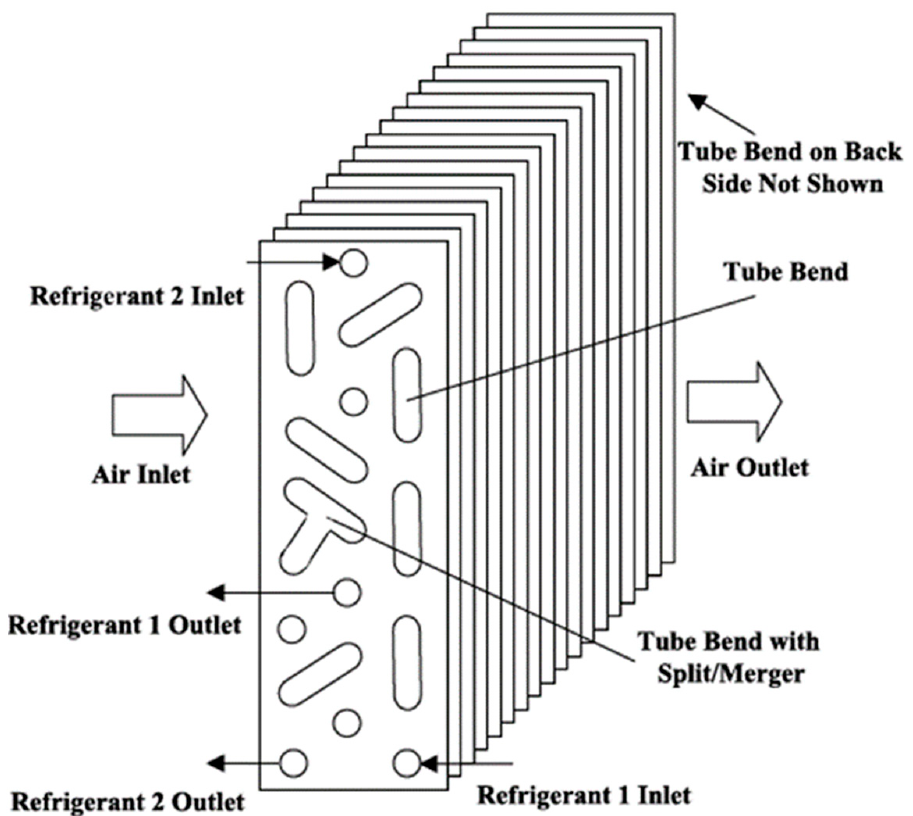
Figure 6. Representation of a finned tube coil for modeling [34].